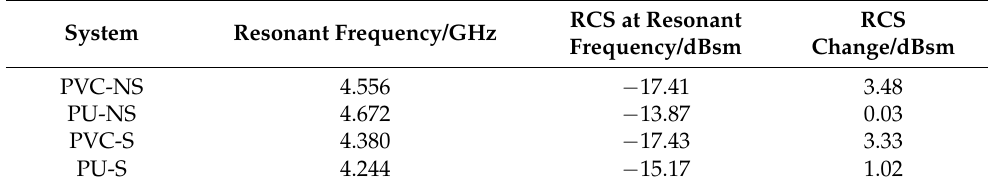
Table 3. Results of initial simulations.